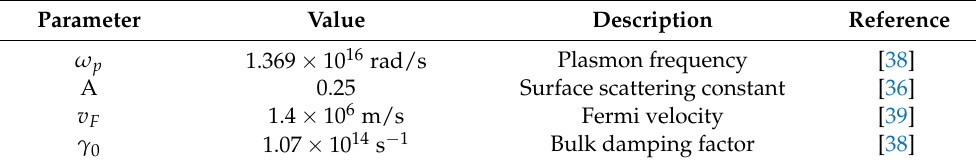
Table 1. Bulk parameters for AuNRs.